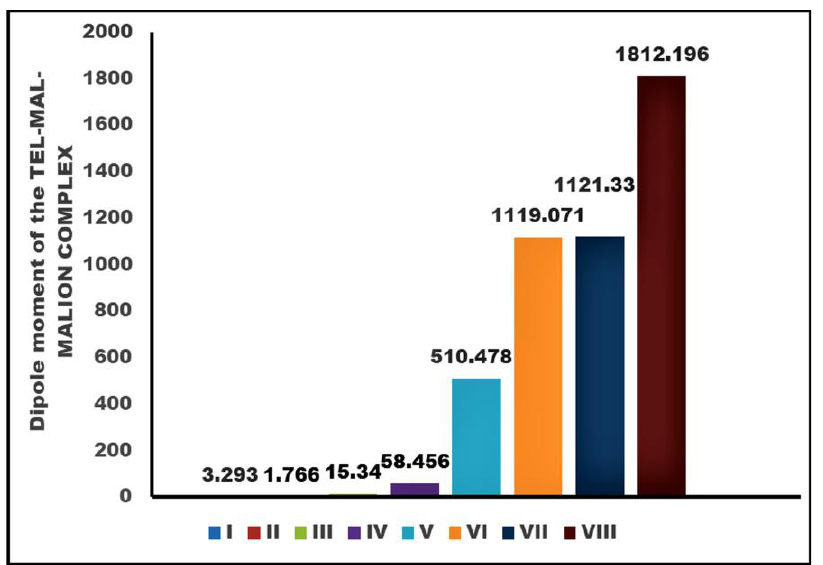
Figure 3. Dipole moment comparison of the co-crystallizing system [(I-Solitary TEL used for docking and complexation); (II-Solitary MAL); (III-Solitary MALION); (IV-TEL:MAL:MALION